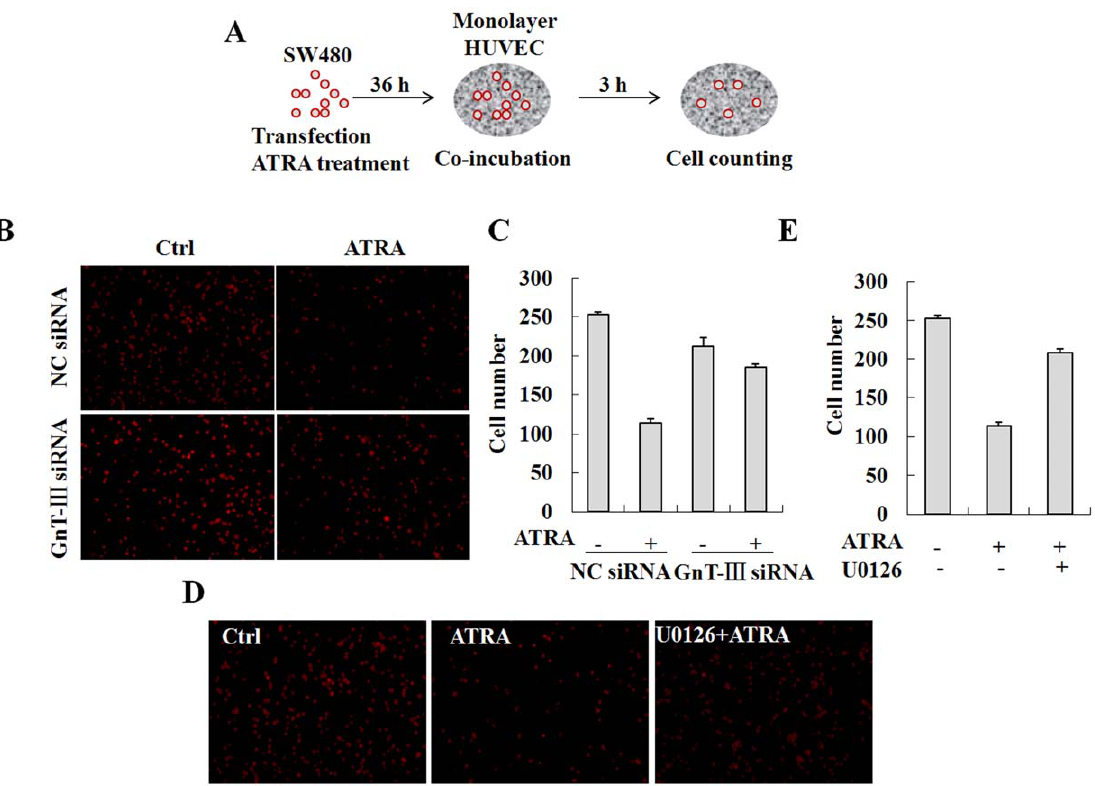
Figure 4. Inhibition of ICAM-1 N -glycan elongation or processing by ATRA suppresses cell adhesion. A, Schematic presentation of the protocol used to determine the effect of ATRA on cell adhesion. Briefly, SW480 cells were transfected with the GnT-III specific siRNA, treated with ATRA and then co-incubated with the HUVEC monolayer. The cell adhesion was assessed by counting the cells attached to the HUVEC monolayer. B, The cells attached to the HUVEC monolayer were observed under a confocal microscope. C, The adherent cells were analyzed by cell counting. D, SW480 cells were pretreated with 10 m M U0126 and then with 25 m M ATRA. The cells attached to the HUVEC monolayer were observed under a confocal microscope. E, The adherent cells were analyzed by cell